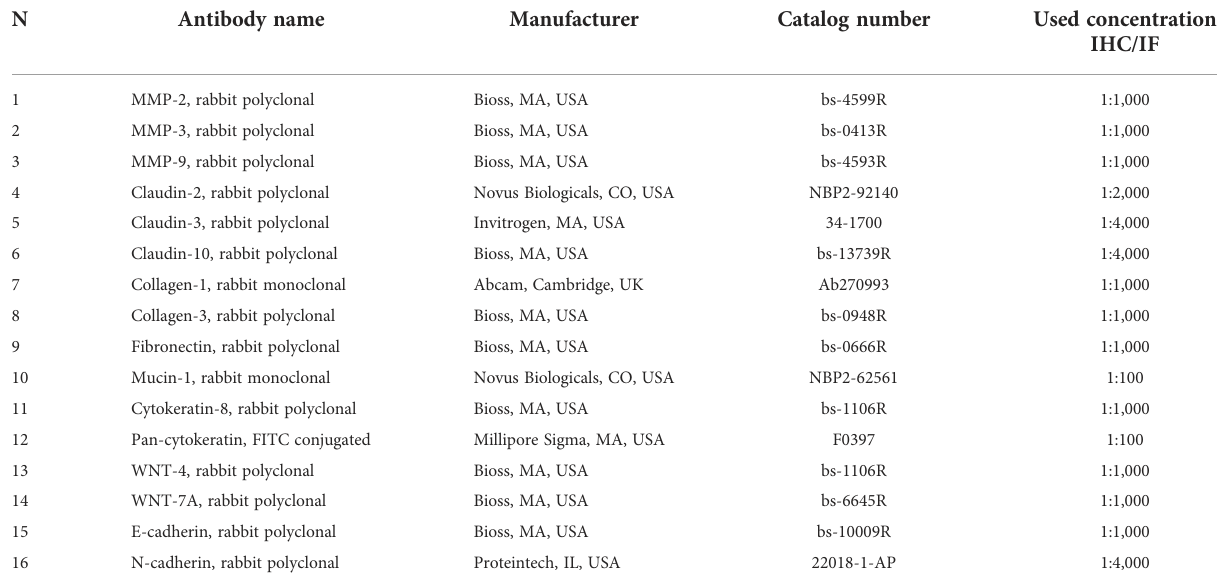
TABLE 1 Antibodies.